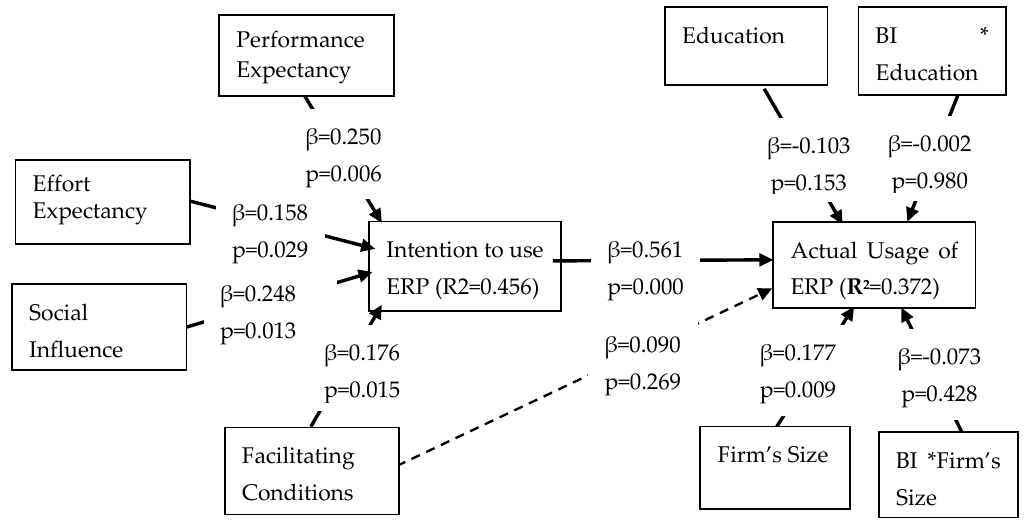
Figure 3. Moderating effects of education and firms’ size in the structural model.